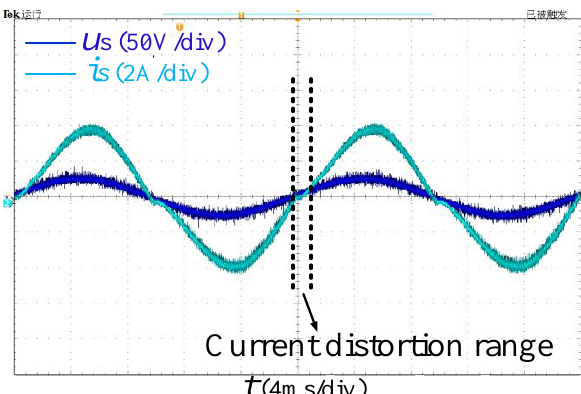
Figure 22. Experiment waveforms of grid voltage and input current under unity power factor.